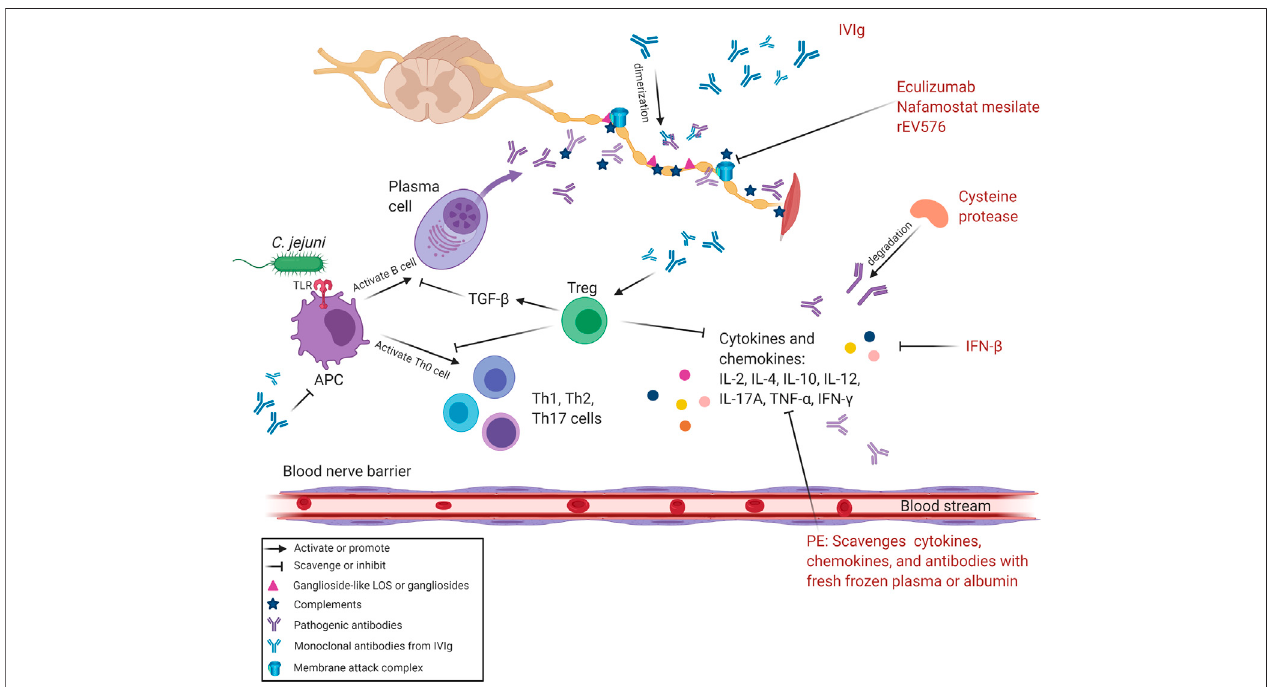
FIGURE 3 | Pharmacological therapeutic targets of GBS. The hyperreactive cellular and/or humoral immune responses in GBS are the main targets of current pharmacological interventions. IVIg can inhibit the production of pathogenic antibodies and pro-in fl ammatory mediators released by T helper cells and activated B cells via functioning on Tregs. IVIg also promotes the dimerization of antiganglioside antibodies and inhibits APCs to alleviate immune responses. PE mainly replaces plasm rich in antiganglioside antibodies and pro-in fl ammatory mediators with fresh frozen plasma/albumin. Eculizumab, nafamostat mesilate, and rEV576 are complement inhibitors that can prevent MAC formation. IFN- β attenuates in fl ammation induced by cytokines and chemokines. Cysteine protease degrades pathogenic antibodies and mitigates hyperreactive immune responses. Abbreviations:APC, antigen-presentingcell; C.jejuni, Campylobacter jejuni ; GBS, Guillain – Barré syndrome; IFN- β , interferon β ; IL, interleukin; IVIg, intravenous immunoglobulin; LOS, lipo-oligosaccharide; MAC, membrane attack complex; PE, plasma exchange; TGF- β , transform growth factor β ; Th cell, T helper cell; TLR, Toll-like receptor; TNF- α , tumor necrosis factor- α ; Treg, regulatory T